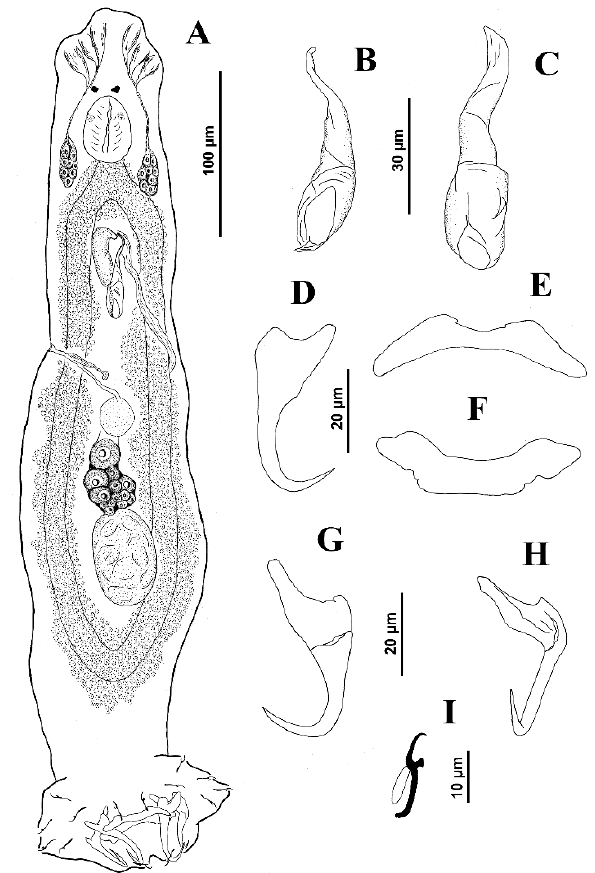
Figure 9. Haliotrema brevicirrus Zhukov, 1980 from the Spotfin butterflyfish Chaetodon ocellatus ( A ) Whole mount (composite, ventral view) ( B , C ) Copulatory complexes ( D ) Ventral anchor ( E ) Ventral bar ( F ) Dorsal bar ( G ) Dorsal anchor ( H ) Dorsal anchor with base slightly bent toward the midline of haptor ( I ) Hook.